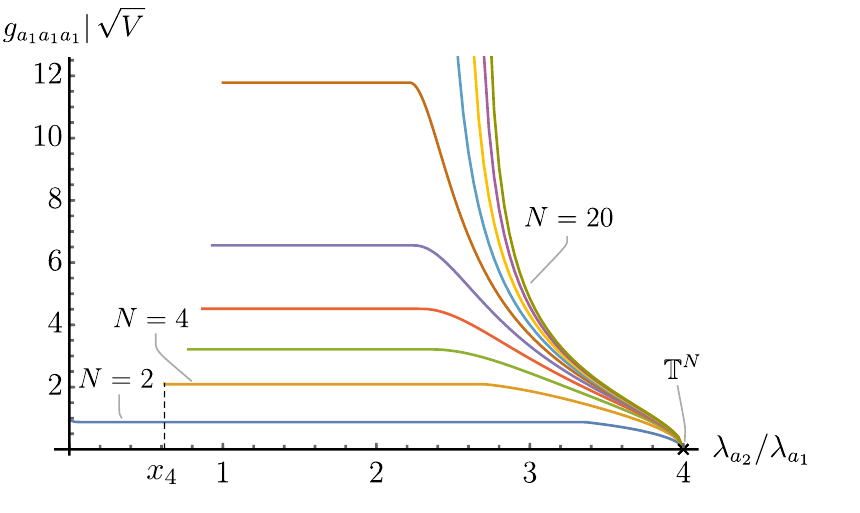
jp V for closed Einstein manifolds with R (cid:21) 0 and N = 1 a 1 a 1 g [ [ (cid:21) a ; 1 1 2